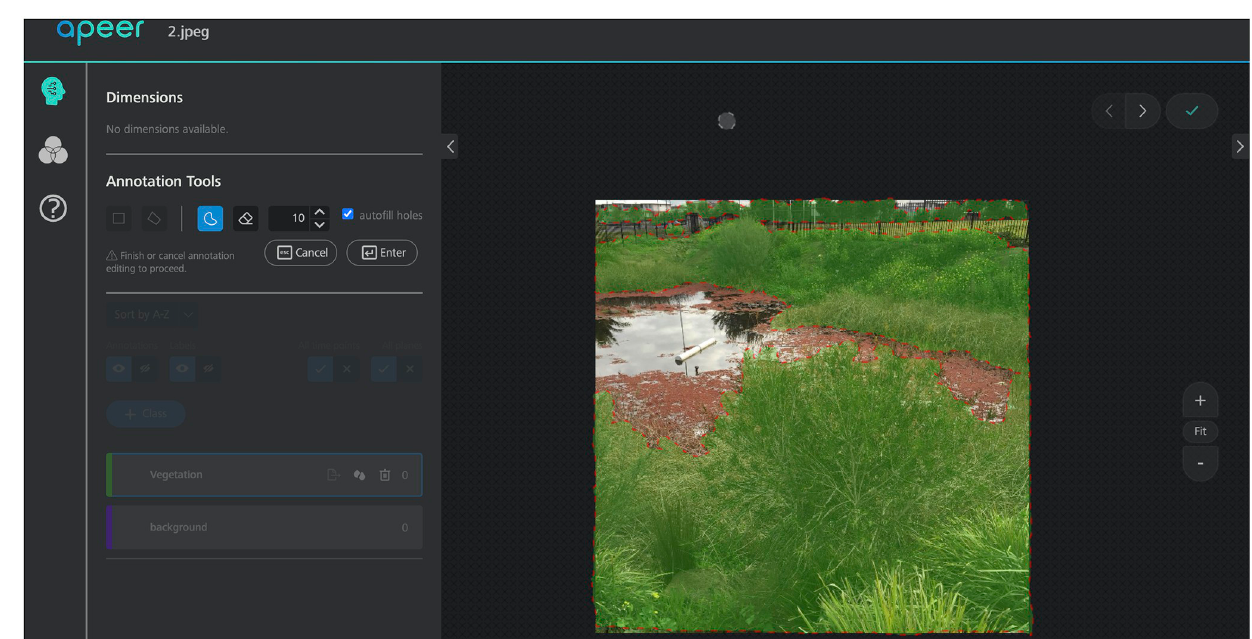
Fig 8. Apeer, an annotation tool’s interface, and a sample annotated image.